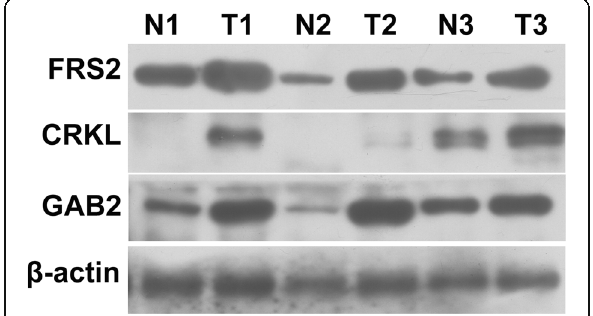
Fig. 2 Western blot analyses of GAB2, CRKL and FRS2 expression in PDAC and matched normal tissues. T: PDAC tissue; N: peritumor normal tissue. β -actin was used as a loading control